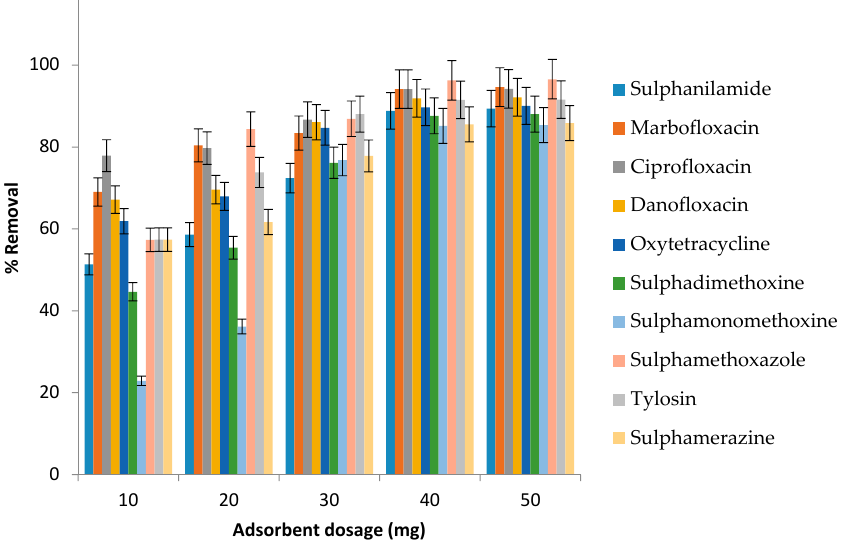
Figure 4. Effect of adsorbent dosage on percentage removal of antibiotics using water-soluble protein powder (n=5).